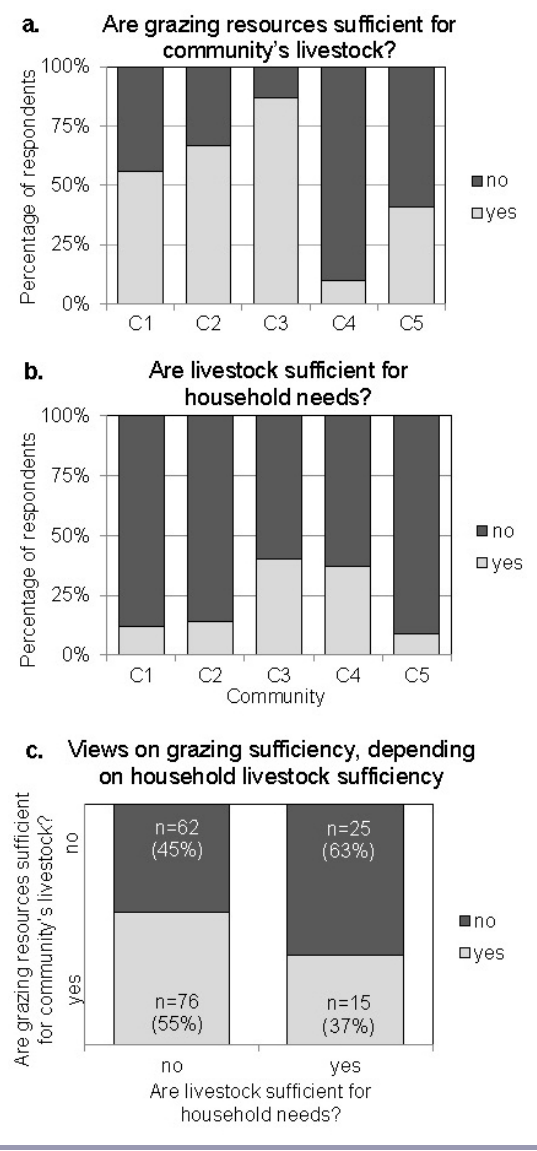
Fig. 2 . Community member responses regarding sufficiency of (a) grazing resources in the community and (b) household livestock resources. Numbers of respondents were 25, 49, 30, 40, and 34 for communities C1 through C5. Panel (c) presents the 2 x 2 contingency analysis of grazing sufficiency responses by livestock sufficiency responses, for all communities combined. The columns separate respondents according to their perceptions of livestock sufficiency, and the dark/light division within columns shows their perceptions of grazing resource sufficiency household. In each block, sample size and percentage of column total are given. All contingency analyses (panels a, b, c) were significant at the α = 0.05 level; see Results for